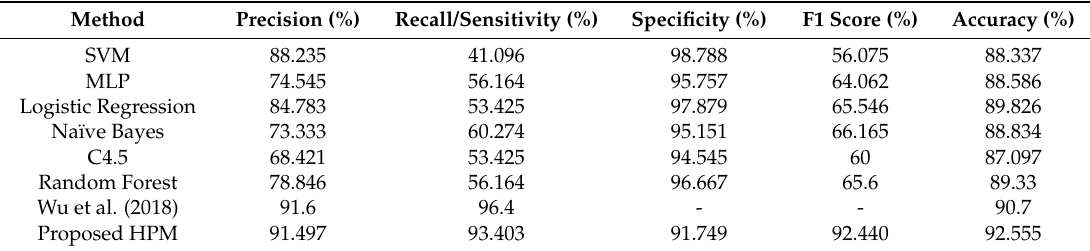
Table 8. Performance evaluation of classification model for dataset